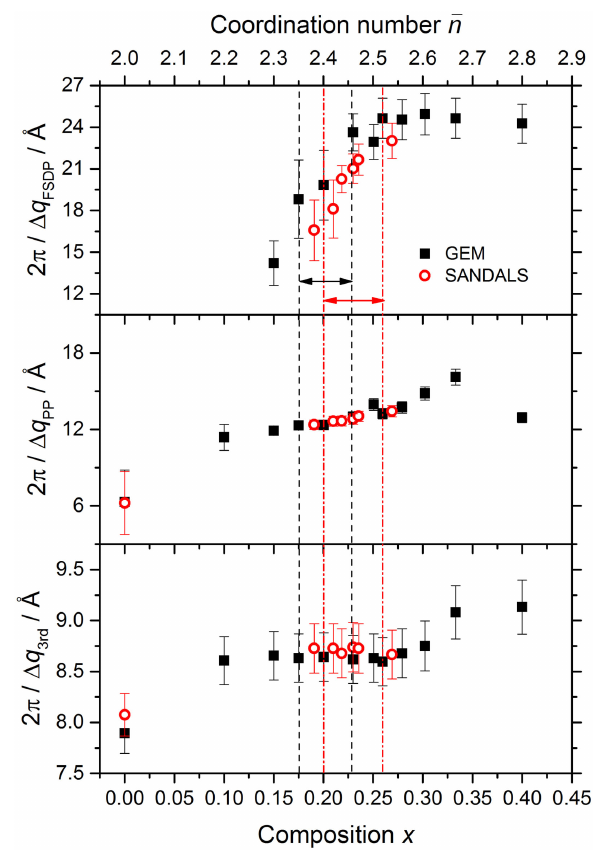
FIGURE 8 | The dependence of the correlation length 2 (cid:25) / ∆ q i associated with the FSDP, principal peak (PP) and third peak in S ( q ) on the composition x and mean coordination number ¯ n = 2 ( 1 + x ) . The results were obtained using either the GEM or SANDALS diffractometer. The pairs of vertical dashed (black) or chained (red) lines, and associated horizonal arrows, mark compositions for which ∆ H nr ≃ 0 as found in the present work or in the work of Boolchand et al. (2001a), respectively. log 10 (cid:17) ( T L ) at x ∼ 0.2 is also indicated if m visc is taken from